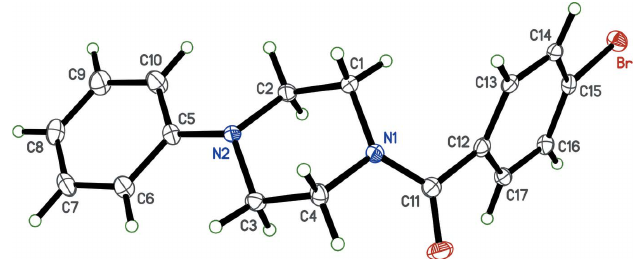
Figure 2 An ellipsoid plot (50% probability) of II .